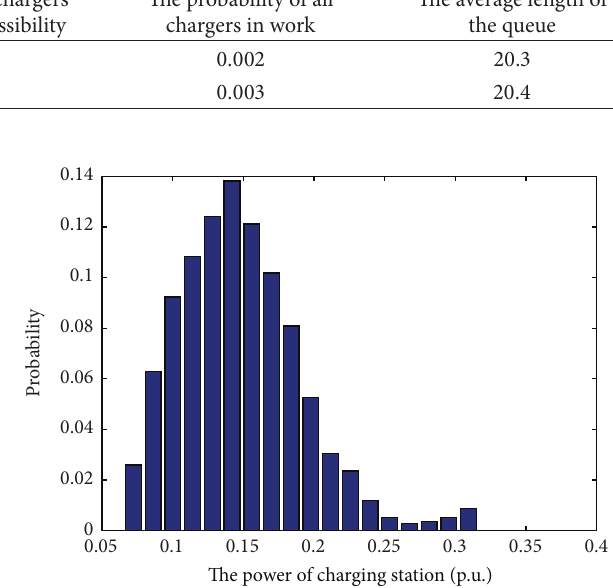
Figure 9: The probability distribution of charging station’s power during daytime.